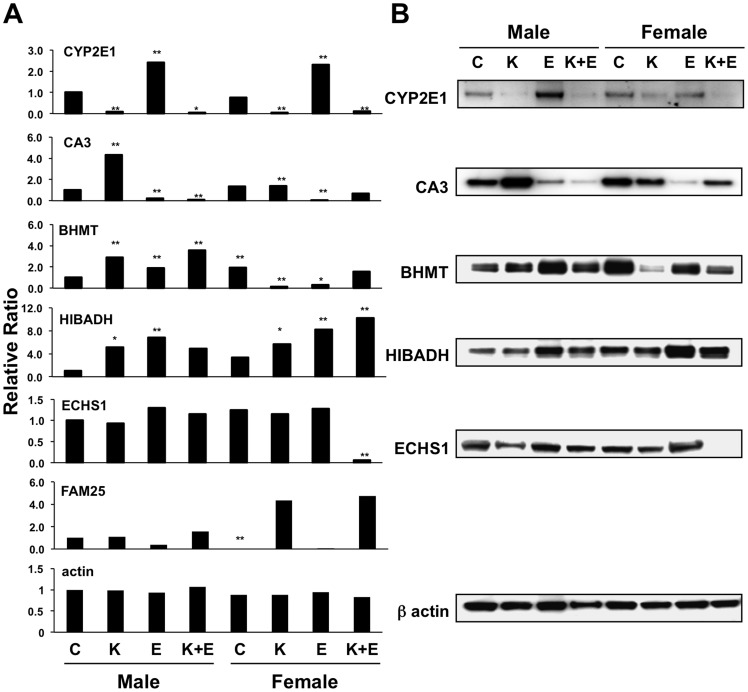
Quantitative analysis of the top six proteins according to Hotelling's T2 test, CYP2E1, CA3, BHMT, HIBADH, ECHS1 and FAM25 in the eight mice models.(A) iTRAQ labeling mass spectrometry results of the top six proteins. All values are relative to control mice (Dextrose diet, wild-type, male mice), *p<0.05 and **p<0.01. (B) Western blot of the same six proteins except FAM25 (no commercial antibody available). β-Actin was used as the loading control. C, control; K, CYP2E1 knockout; E, ethanol.